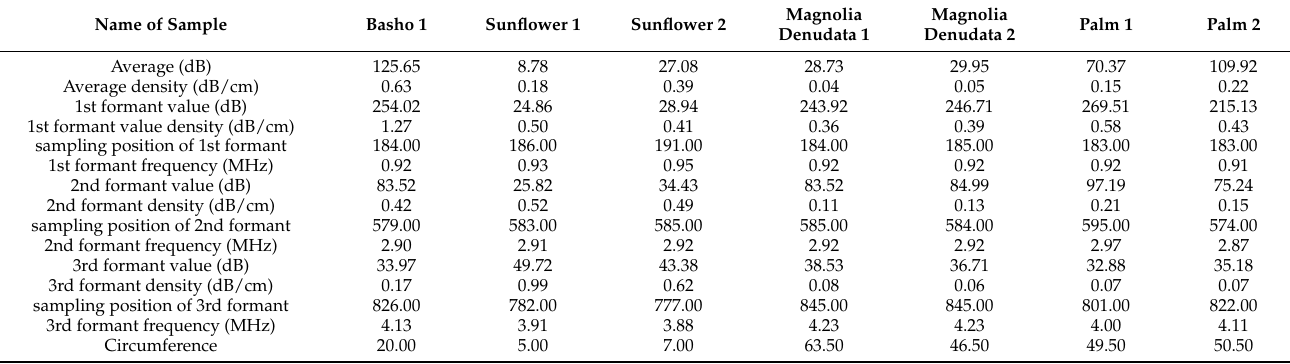
Table 6. Ultrasound features of plant stems in frequency domain.